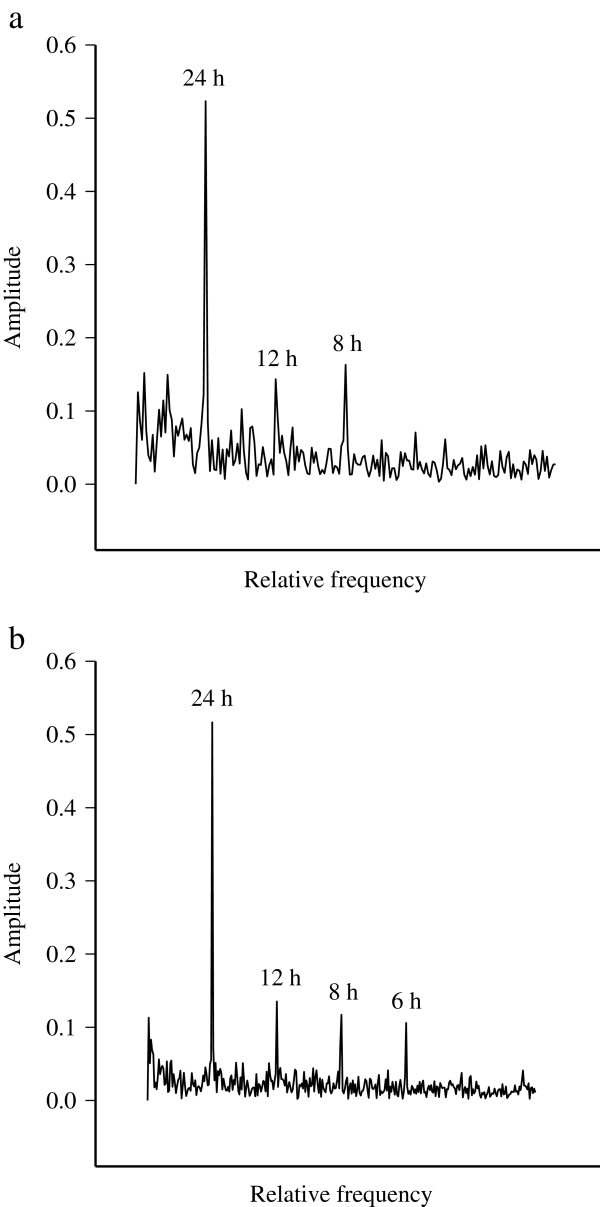
Representative body temperature amplitude spectra during overwintering. The body temperature amplitude spectra of an adult male raccoon dog (M1) during (a) active and (b) passive periods of wintering.